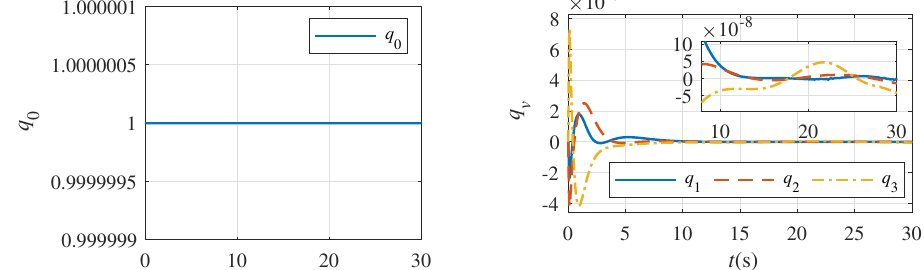
Figure 9. The response curve of attitude quaternion.